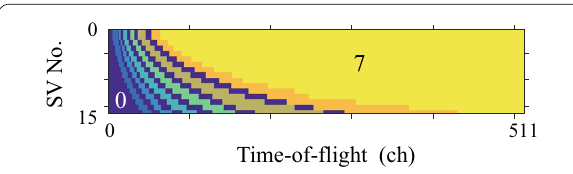
Fig. 13 Mass-per-charge ( m/q ) table of the 16 SV steps and 512 TOF channels used for the allocation of the 8 m/q bins in the Normal mode. The 8 colors indicate the m/q -bin